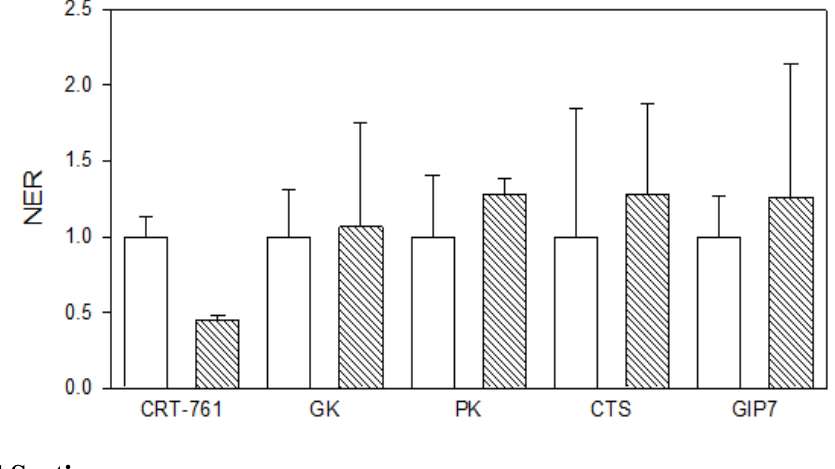
Figure 8. Effect of Mi-CRT silencing on the expression of metabolism genes. The normalized expression rates (NER) of Mi-CRT , glycerol kinase ( GK ), pyruvate kinase ( PK ), citrate synthase ( CTS ) and Gex interacting protein 7 ( GIP7 ) genes were quantified by Reverse Transcription-quantitative PCR. White bars: transcript levels after soaking in control siRNA. Oblique striped bars: transcript levels after soaking in siRNA CRT-761. Error bars: standard error of the mean (SEM). For each soaking condition, histograms show the mean and its standard error calculated on technical duplicates done on three first strand cDNA templates obtained from three RNA